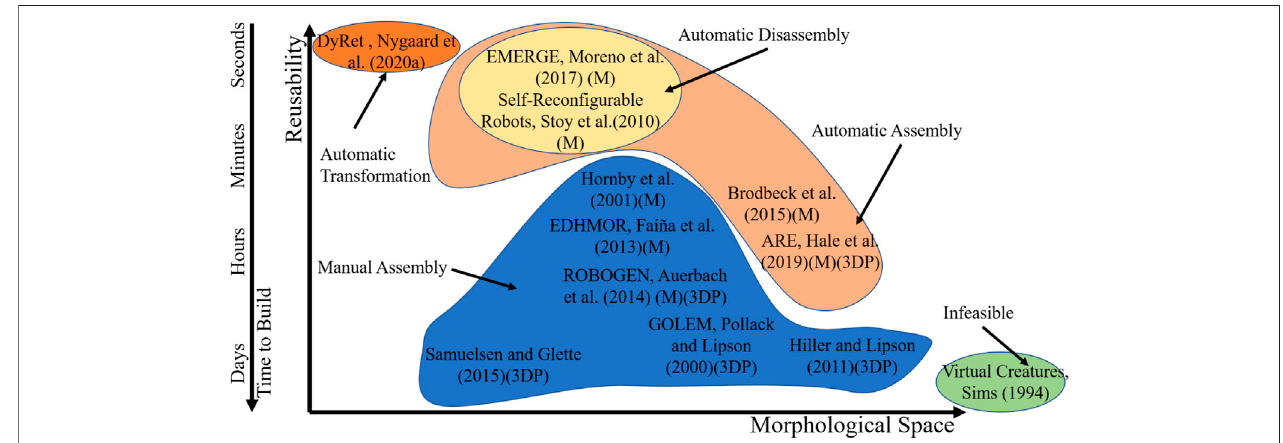
FIGURE 12 | Comparison of real world robot evolution testing approaches. (M) Modular, (3DP) 3D printed.